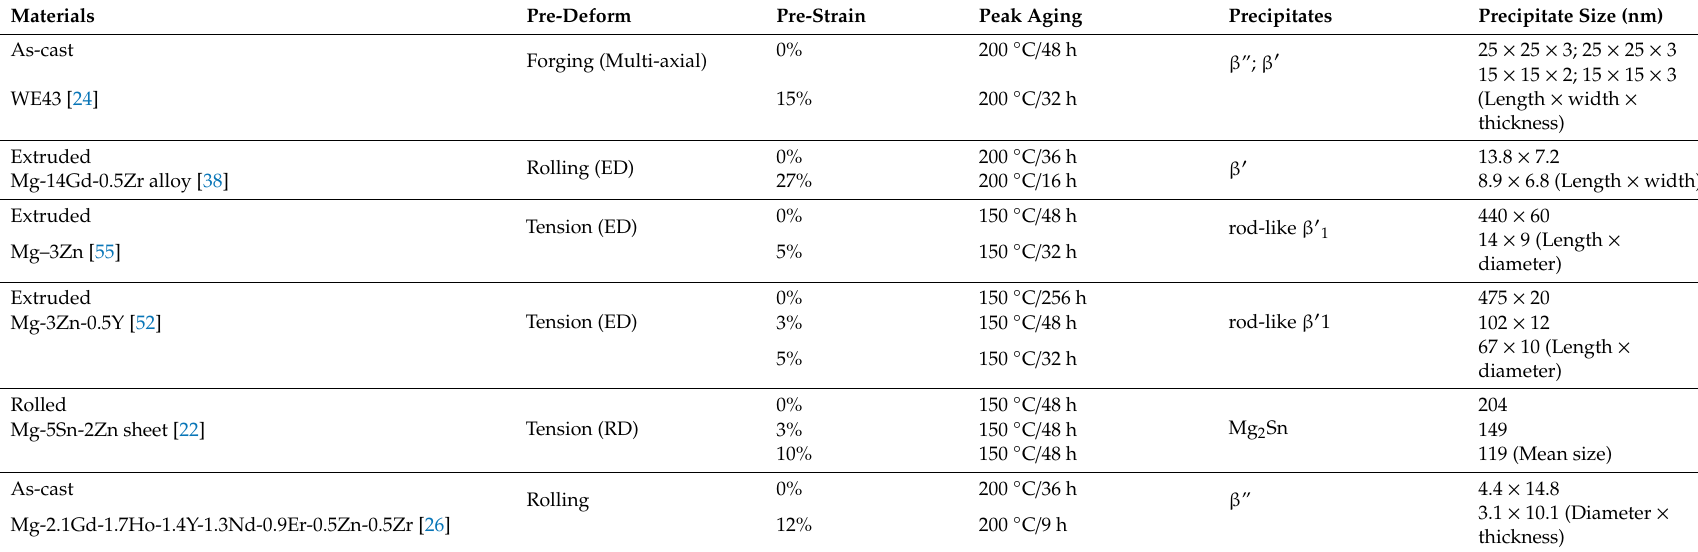
Table 2. Influence of pre-cold deformation on peak aging time and precipitate